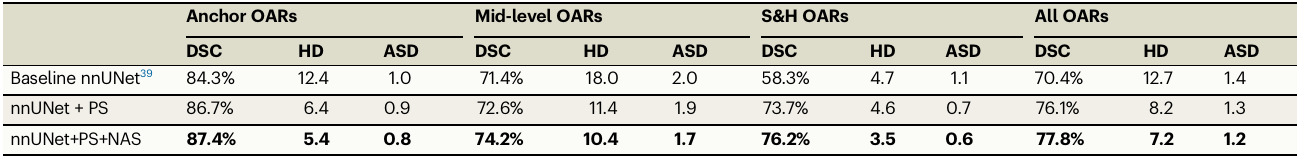
Table 2 | Quantitative results of the ablation evaluation using the validation set of the training-validation